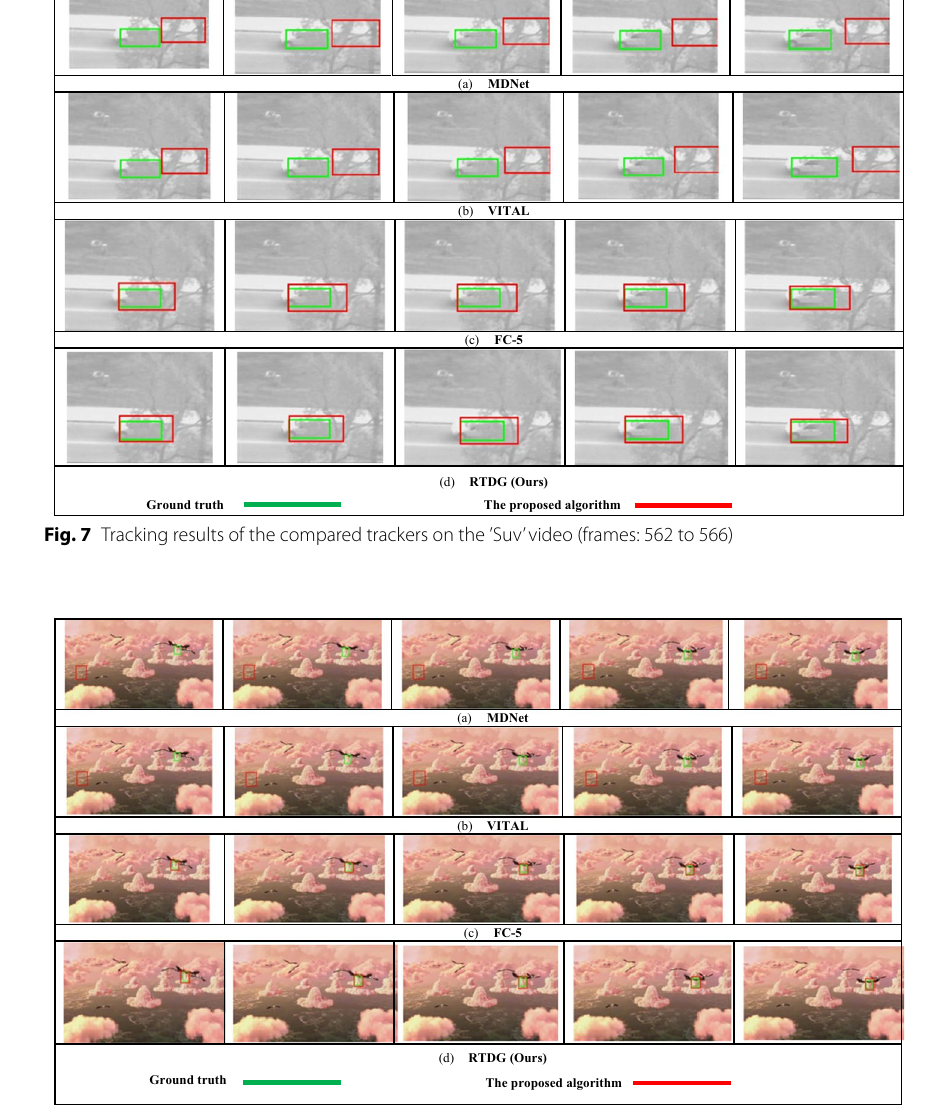
Fig. 8 Tracking results of the compared trackers on the ’Bird 1’ video (frames: 280 to